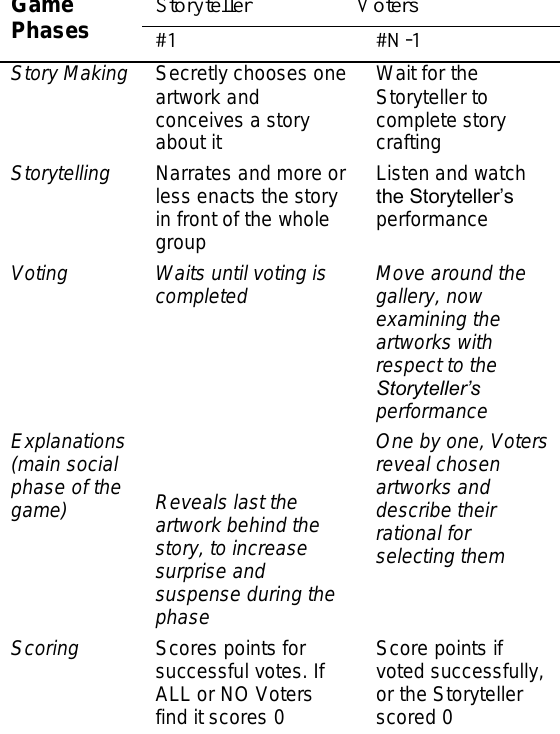
Table 1. Game phases per Storyteller turn & corresponding actions under each player